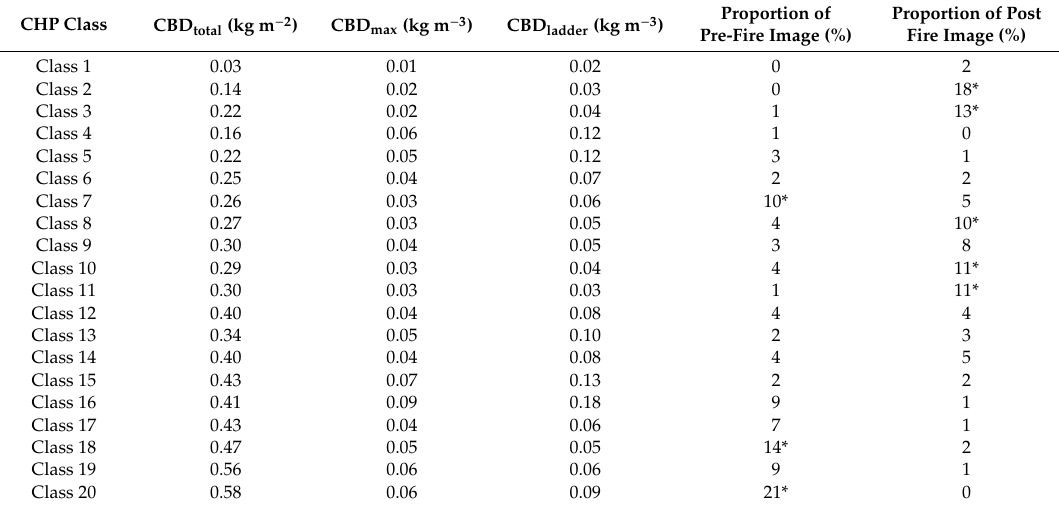
Table 2. Statistics of the 20 Canopy classes, including the percentage of the class found in the study area before and after the fires. Cells with a proportion of the area greater or equal to 10% are denoted with an “*”.